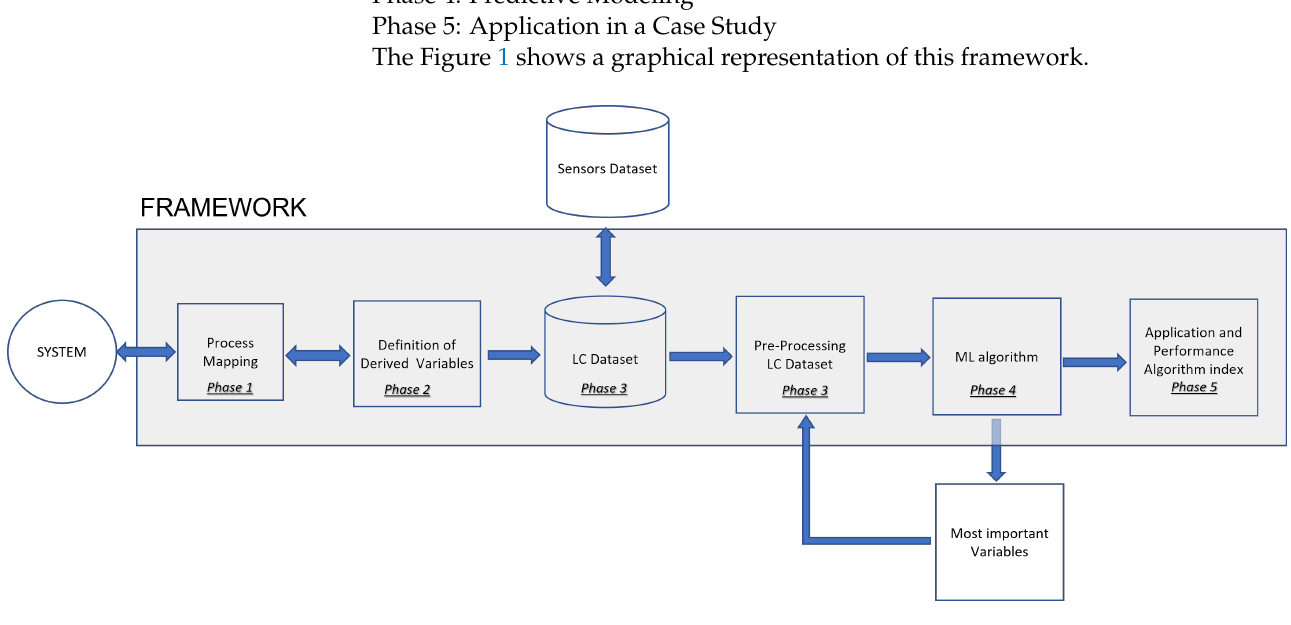
Figure 1. Framework